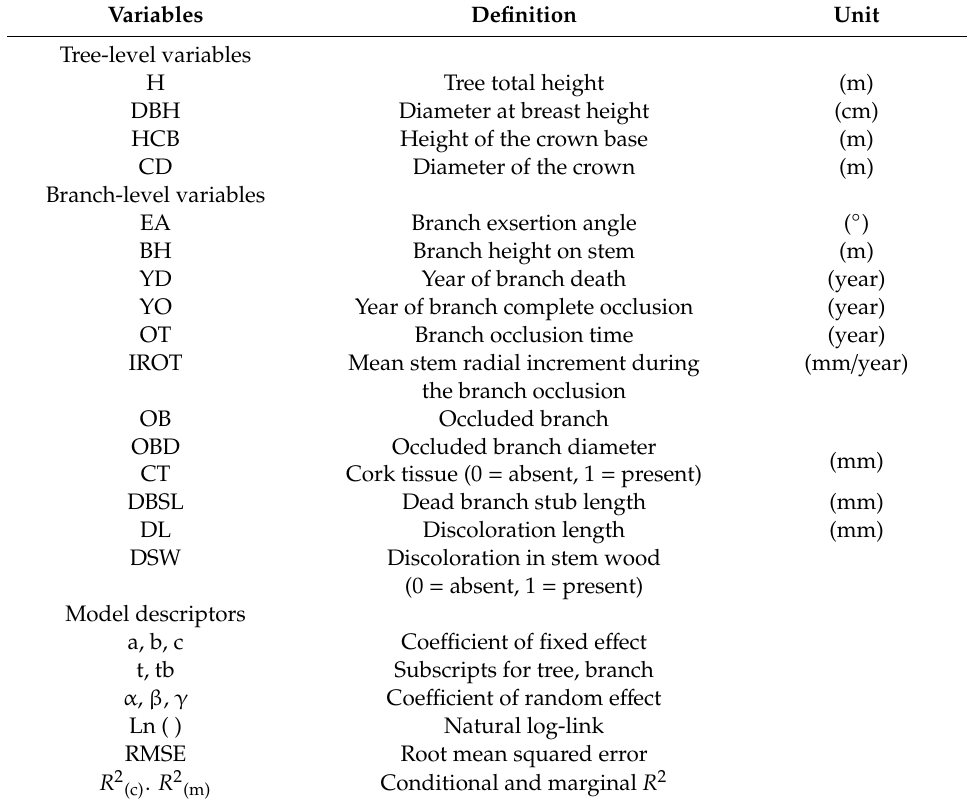
Table 1. Variable